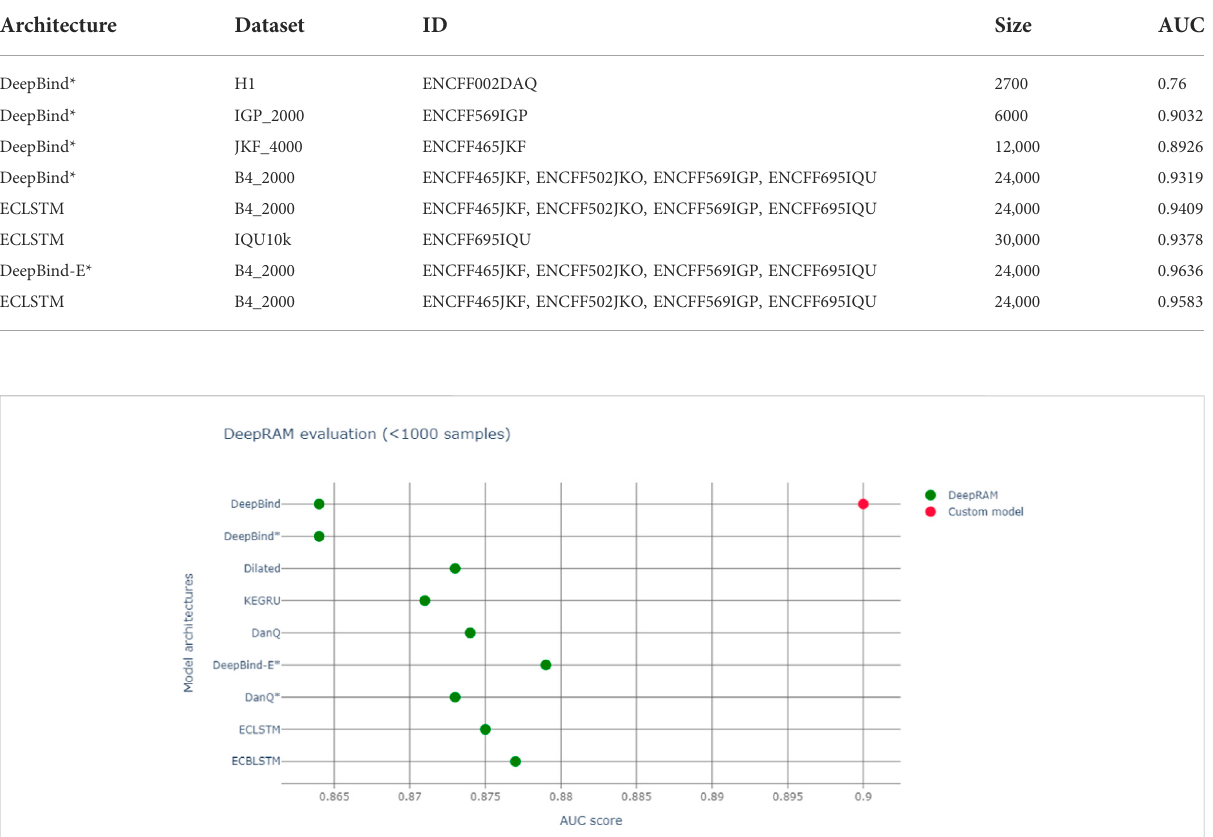
TABLE 1 Our DeepBind models on myc and AUC.